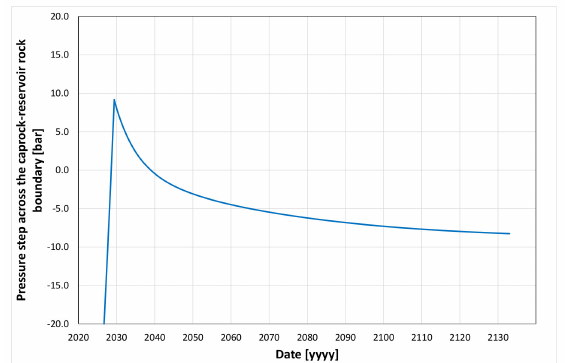
Figure 43. Pressure step across the caprock–reservoir rock boundary at the high structure point.